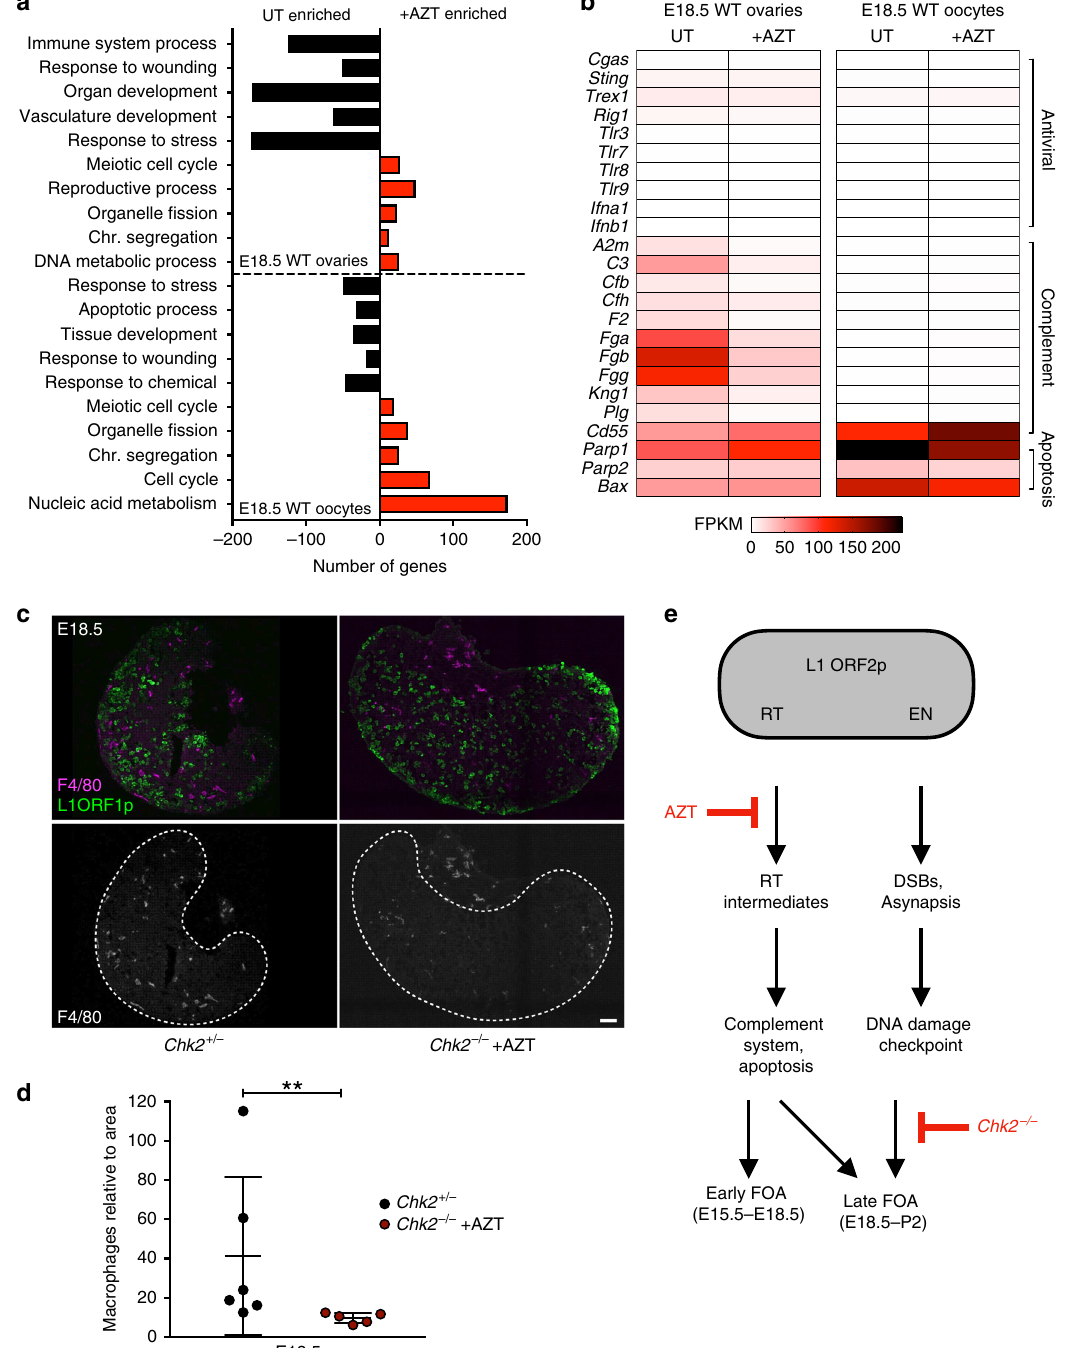
Fig. 2 Mechanisms of AZT-sensitive FOA. a GO enrichment in untreated (UT) and AZT-treated E18.5 ovaries and oocytes. b mRNA abundance (FPKM) in UT and AZT-treated E18.5 ovaries and oocytes for immunity and apoptosis genes. a, b Analysis from mRNA-sequencing data containing n > 2 biological replicates sequenced per condition, each containing sorted oocytes or ovaries from > 6 WT CD1 embryos. c Immuno fl uorescence labeling of macrophage marker F4/80 and L1 ORF1p-labeling oocytes in E18.5 Chk2 + / − and Chk2 − / − + AZT ovaries. Ovaries are separated from surrounding tissue for quanti fi cation of macrophages in ovary with dotted line, boundary determined using L1 ORF1p as a marker of oocytes. Scale bar:50 μ m. d Quanti fi cation of macrophage number per ovary section area in Chk2 + / − ( n = 6) and Chk2 − / − + AZT ( n = 5) conditions. Dots indicate independent ovary sections from three ovary samples per condition; data are mean + SD. Stats by Mann – Whitney test, ** p < 0.01. e Model of L1 ORF2p activities and their relationship to molecular triggers and mechanisms of FOA. Reverse transcriptase (RT) activity of ORF2p is inhibited by AZT and associated with L1 reverse transcription intermediates, activation of the complement system and recruitment of immune cells. Endonuclease (EN) activity of ORF2p creates DNA breaks that in addition to other common meiotic defects, activates the DNA damage checkpoint through